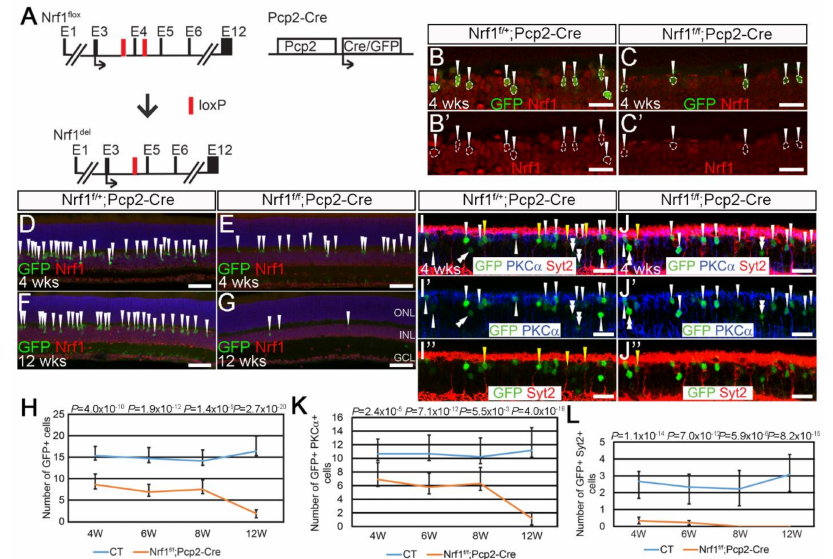
Figure 4. Nrf1 conditional deletion by Pcp2-Cre causes rapid degeneration of type 2 and 6 cone bipolar cells. ( A ) Schematic illustration of Nrf1 flox , Nrf1 del , and Pcp2-Cre alleles. Exons are indicated as E1–E12. Black arrows indicate the translational start sites for Nrf1 and Cre protein. Red boxes indicate loxP sites. ( B , C ) Immunostaining of 4-week-old Nrf1 f/+ ; Pcp2-Cre ( B , B (cid:48) ) and Nrf1 f/f ; Pcp2-Cre ( C , C (cid:48) ) retinas with anti-GFP ( B , C ) and anti-Nrf1 ( B , B (cid:48) , C , C (cid:48) ) antibodies. GFP + cells are indicated with arrowhead. ( D – G ) Immunostaining of 4- and 12-week-old Nrf1 f/+ ; Pcp2-Cre ( D , F ) and Nrf1 f/f ; Pcp2-Cre ( E , G ) retinas with anti-GFP and anti-Nrf1 antibodies. GFP + cells are indicated with arrowheads. ( H ) Number of GFP+ cells of Nrf1 f/+ ; Pcp2-Cre and Nrf1 f/f ; Pcp2-Cre retinas at 4, 6, 8, and 12 weeks old. ( I , J ) Immunos- taining of Nrf1 f/+ ; Pcp2-Cre ( I , I (cid:48) , I (cid:48)(cid:48) ) and Nrf1 f/f ; Pcp2-Cre ( J , J (cid:48) , J (cid:48)(cid:48) ) retinas at 4 weeks old with anti-GFP ( I – I (cid:48)(cid:48) , J – J (cid:48)(cid:48) ), anti-PKC α ( I , I (cid:48) , J , J (cid:48) ), and anti-Syt2 ( I , I (cid:48)(cid:48) , J , J (cid:48)(cid:48) ) antibodies. GFP + PKC α + cells, GFP + Syt2 + cells, and GFP + PKC α − Syt2 − cells are indicated with white arrowheads, yellow arrowheads, and white double-arrowheads, respectively. ( K ) Number of GFP + PKC α + cells of Nrf1 f/+ ; Pcp2-Cre and Nrf1 f/f ; Pcp2-Cre retinas at 4, 6, 8, and 12 weeks old. ( L ) Number of GFP + Syt2 + cells of Nrf1 f/+ ; Pcp2-Cre and Nrf1 f/f ; Pcp2-Cre retinas at 4, 6, 8, and 12 weeks old. Scale bars: 20 µ m in ( B , B (cid:48) , C , C (cid:48) , I , I (cid:48) , I (cid:48)(cid:48) , J , J (cid:48) , J (cid:48)(cid:48) ) and 50 µ m in ( D – G